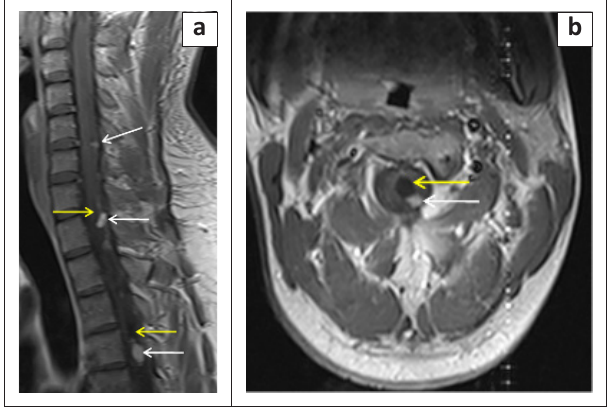
FIGURE 5: Multiple cord haemangioblastoma in a 27-year-old man with von Hippel Lindau syndrome. The contrast-enhanced sagittal T1-weighted image (a) demonstrates multiple enhancing nodules along the cord (white arrows) with associated cystic components (yellow arrows). The contrast-enhanced axial T1-weighted image (b) demonstrates the classic cystic lesion (yellow arrow) with an enhancing mural nodule (white arrow), commonly seen with CNS haemangioblastomas.